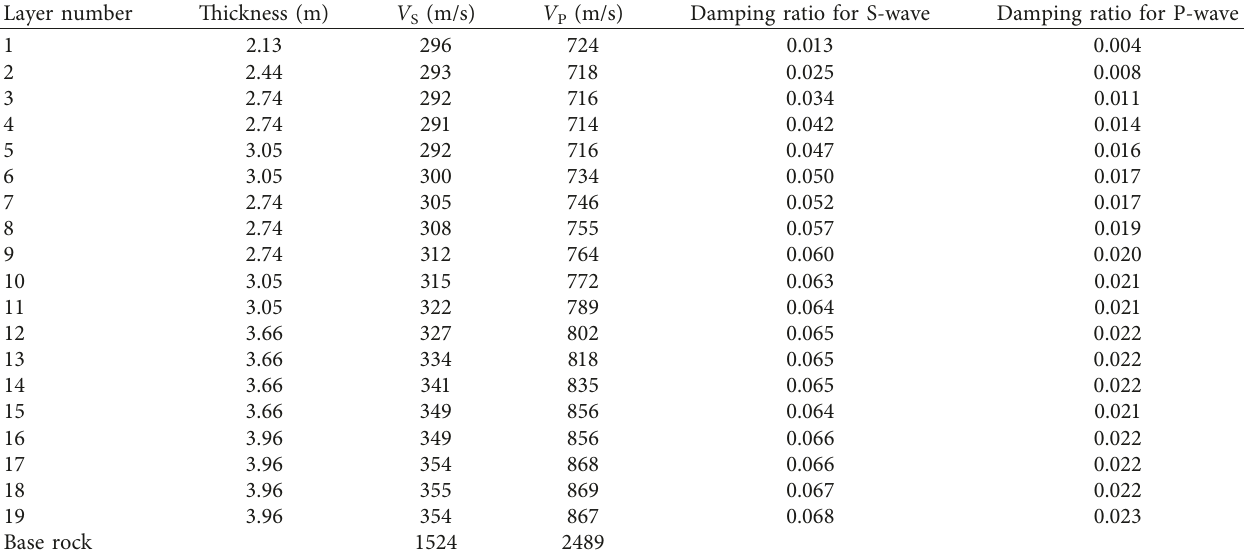
Table 2: Soil layers and properties of the condition